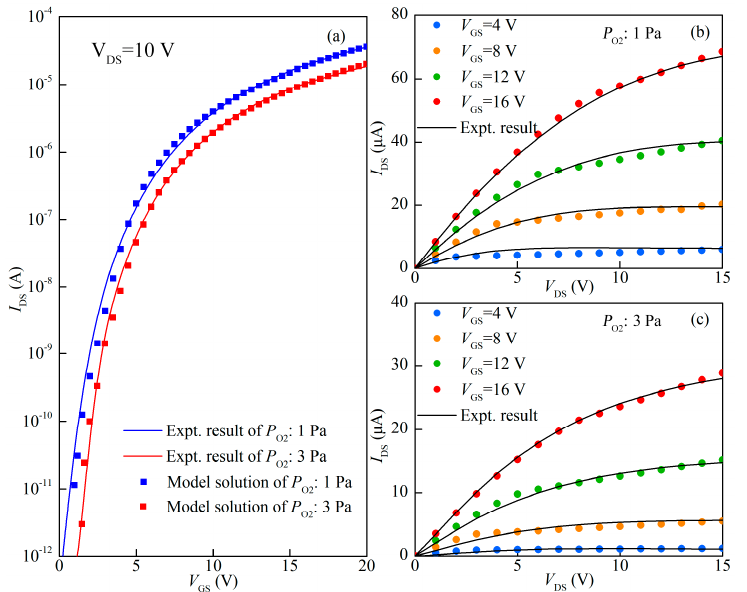
Figure 3. O 1s XPS spectra of a-IGZO thin films fabricated with Po 2 values of ( a ) 1 Pa and ( b ) 3 Pa.